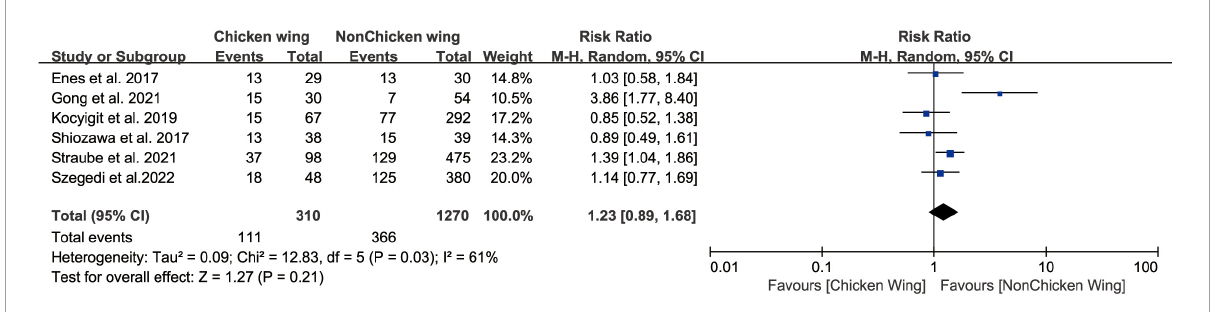
FIGURE2 Forest plot showing the no difference in LAA morphology (chicken vs. non-chicken) between patients with and without AF recurrence after catheter ablation.